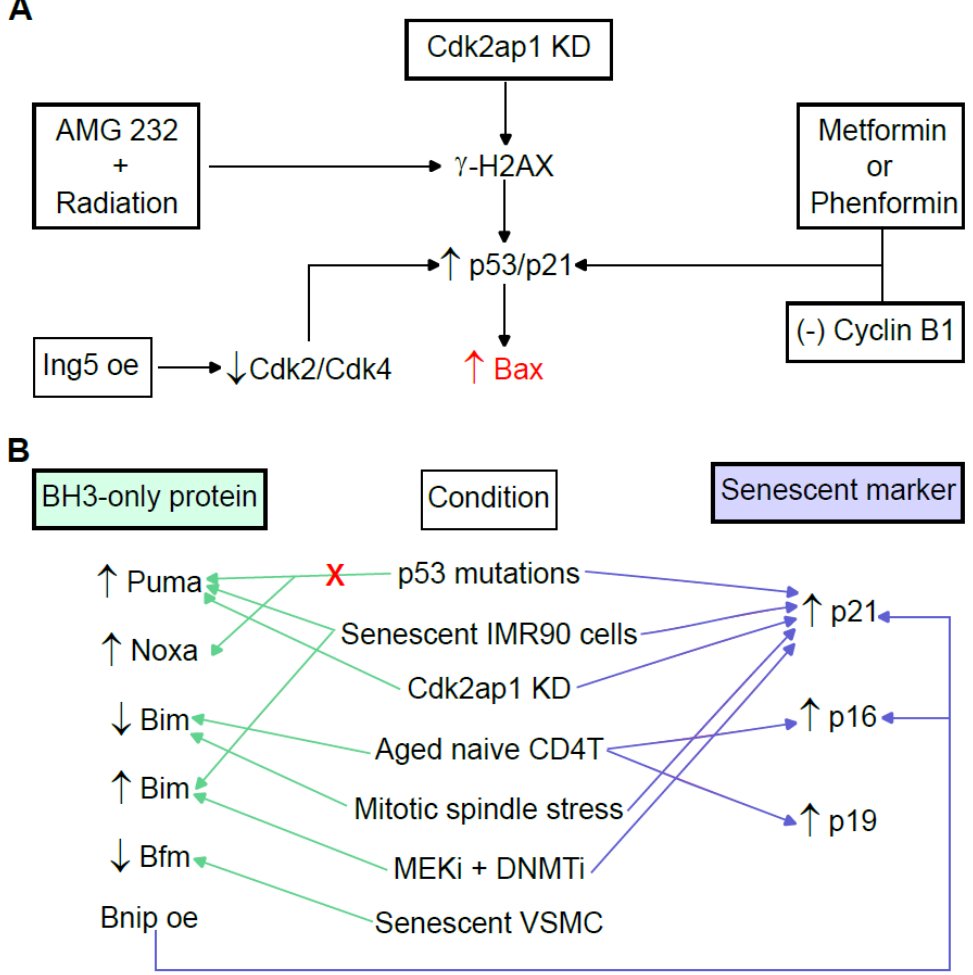
Figure 3. Role of the proapoptotic proteins of the Bcl-2 family. ( A ) Different stimuli activate the H2A histone family member X ( γ -H2AX)/p53/p21/Bax pathway at different levels. The Cdk2ap1 knockdown (Cdk2ap1 KD) and combinatorial treatment of AMG-232 with radiation causes an increase in γ -H2AX. Treatment with metformin or phenformin, as well as inhibition of cyclin B1, causes an increase in the expression of p53 and/or p21. Overexpression of Ing5 (Ing5 oe) results in a lower expression of Cdk2/Cdk4 and higher expression of p53/p21. As a result, senescent cells with elevated Bax expression are obtained in all cases. ( B ) Different senescence conditions result in the differentially modified expression of proapoptotic BH3-only proteins, as well as increased expression of senescent markers. Cdk2ap1, Cdk2-associated protein-1; Ing5, inhibitor of growth protein 5; MEKi, mitogen-activated protein kinase kinase inhibitors; DNMTi, DNA methyltransferase inhibitor; VSMC, vascular smooth muscle cells. Up arrows mean increase, down arrows mean decrease. Additionally, the absence of Bax and Bak can result in the failure of mitotic cell death or a delay in cell division. In both situations, it should be followed by cell cycle